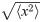
Input-output correlation IOC as a function of the idiosyncratic switching tendency a.The correlation is computed according to Eq (23). Parameter values are h
0 = 10−3, F = 0.02, and three different system sizes, N = 50, 200, 800. A measure of the fraction of time spent by the system near the extremes of the opinion index space, 〈x2〉, is also shown for the N = 200 case. Arrows point at the idiosyncrasy levels whose opinion index time series are shown in Fig 6, marked also by their corresponding letter: a) a = 5 · 10−4, b) a = 5 · 10−3, c) a = 5 · 10−2.